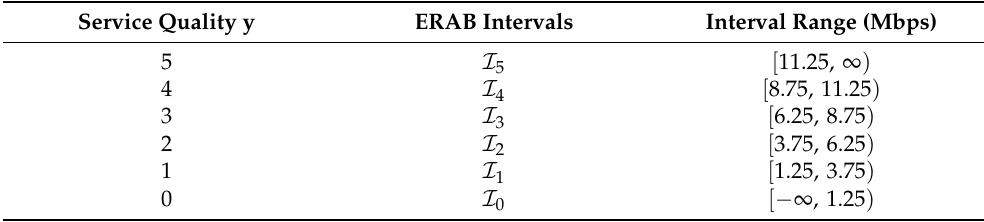
Table 1. An example of service qualities and their corresponding ERAB intervals. In this example, the network system has six service quality levels (i.e., L = 6). The set of thresholds is given as { η } = { 1.25, 3.75, 6.25, 8.75, 11.25 } 1 , . . . , η 5